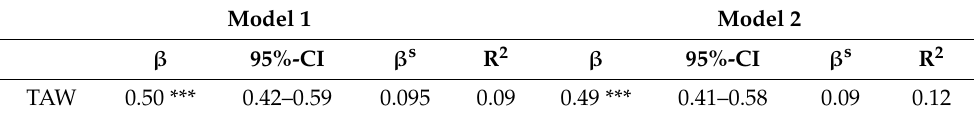
Table 2. Results of the OLS regression on the association between TAW and